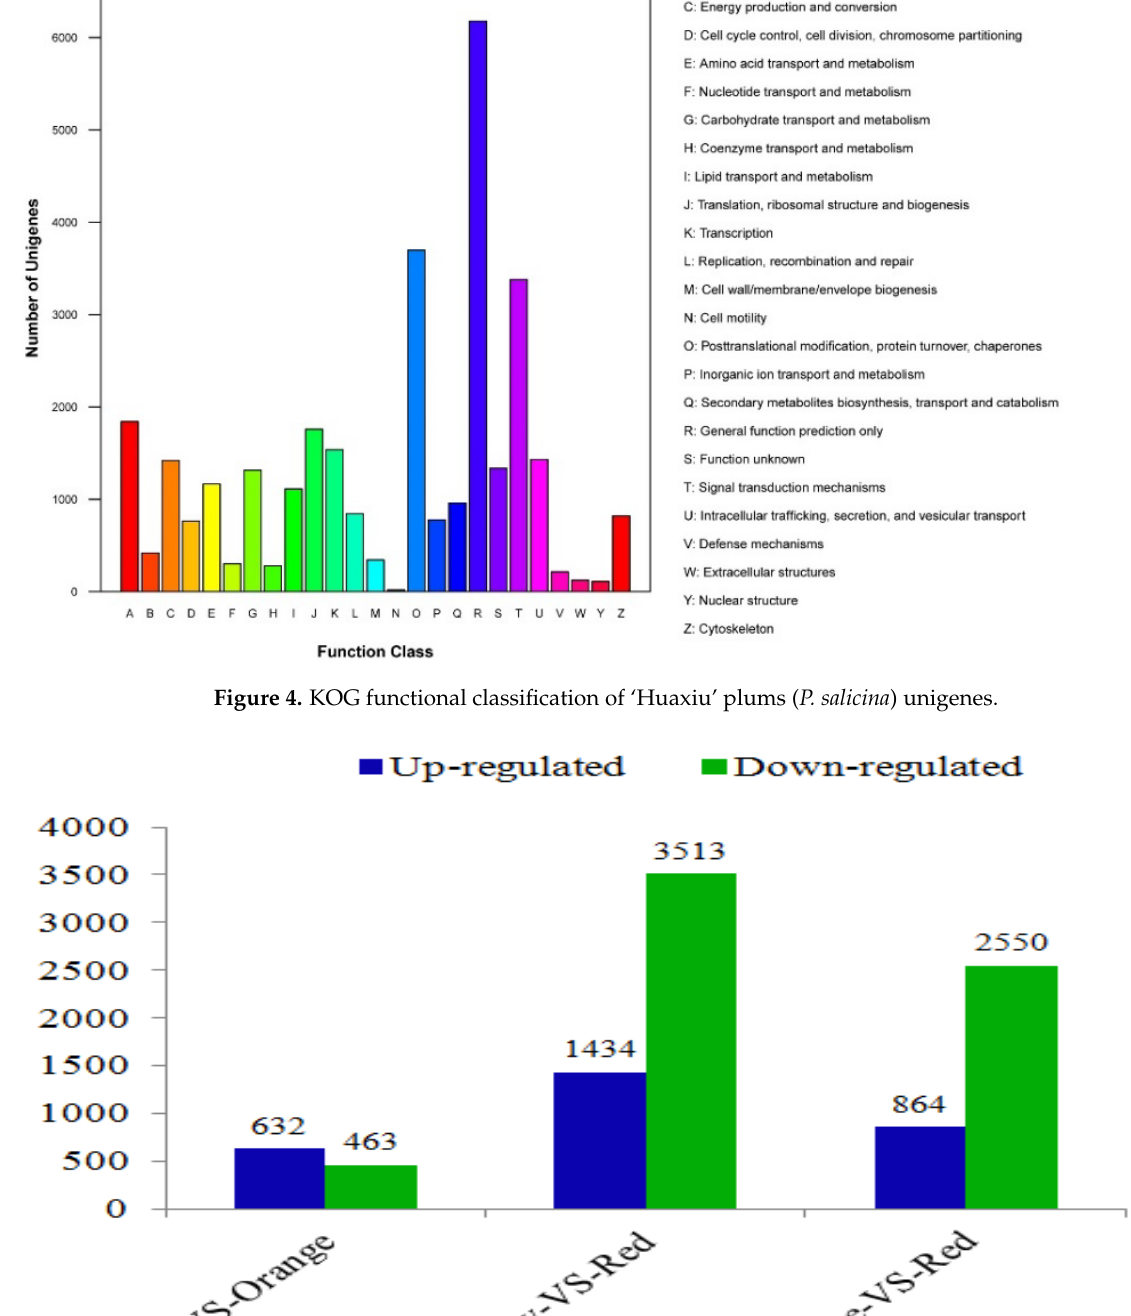
Figure 5. The numbers of DEGs in comparisons of the YS-vs.-OS, OS-vs.-RS, and YS-vs.-RS fruit samples.